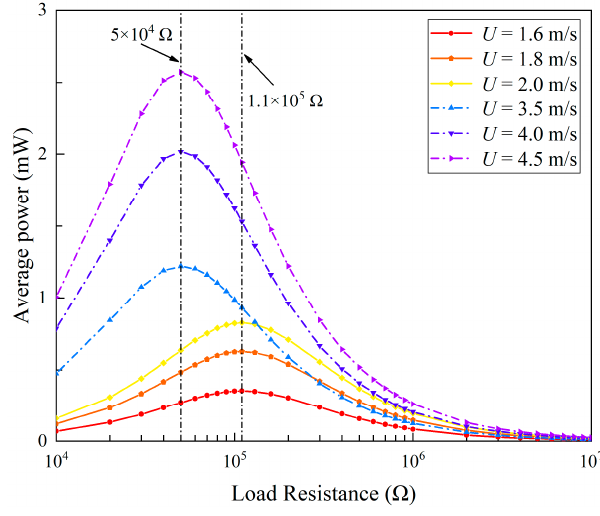
Figure 18. Variation of average power with load resistance at different wind speeds.